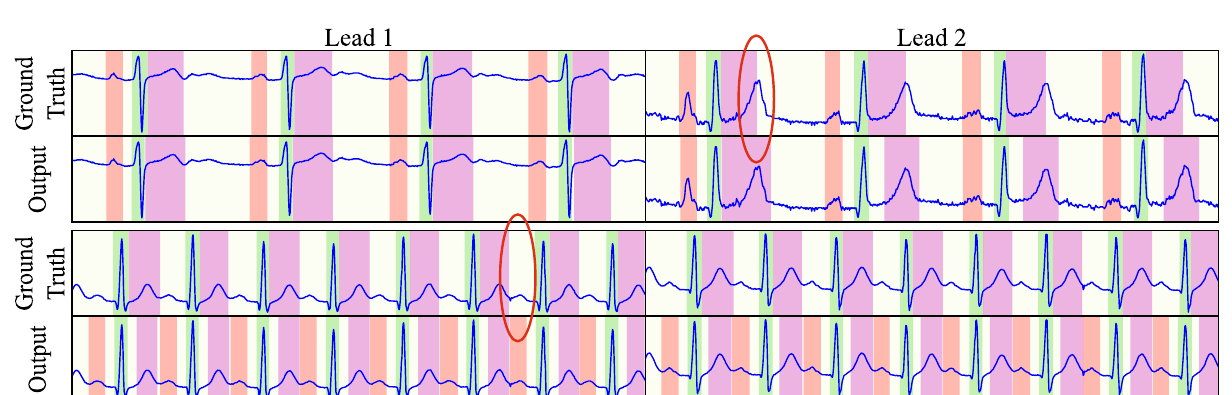
Figure 6. Examples of incorrectly predicted samples, featuring fused T and P waves (top) and severe bradycardia (bottom). Red mask: P wave. Green mask: QRS wave. Magenta mask: T wave. Representative examples have been encircled.